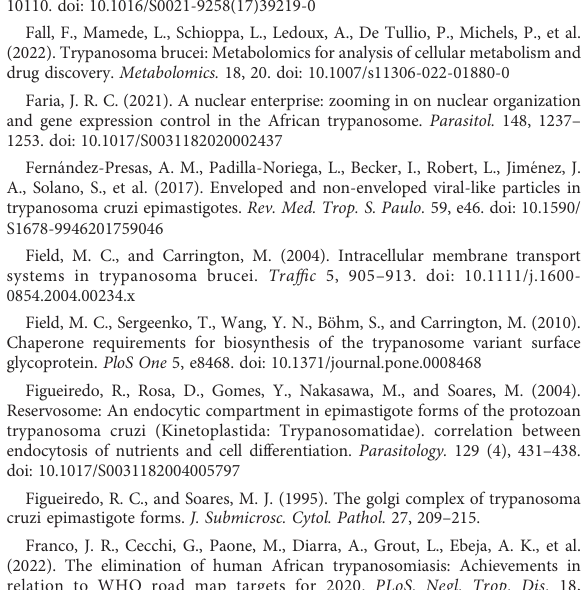
relation to WHO road map targets for 2020. PLoS. Negl. Trop. Dis. 18, e0010047. doi: